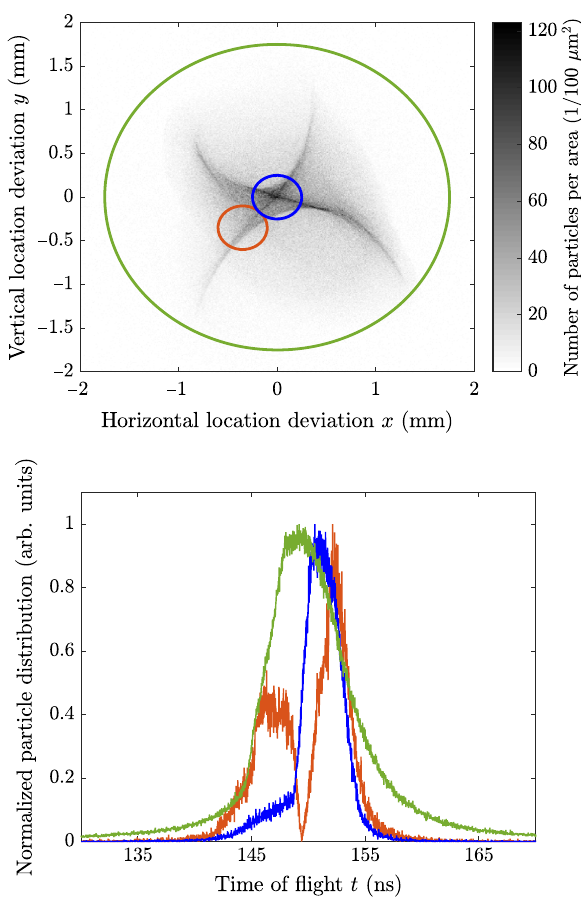
was already shown in Fig. 5, is illustrated as a 2D histogram and the temporal profiles of the beam fractions encircled by the green, blue, and red rings are shown in the lower